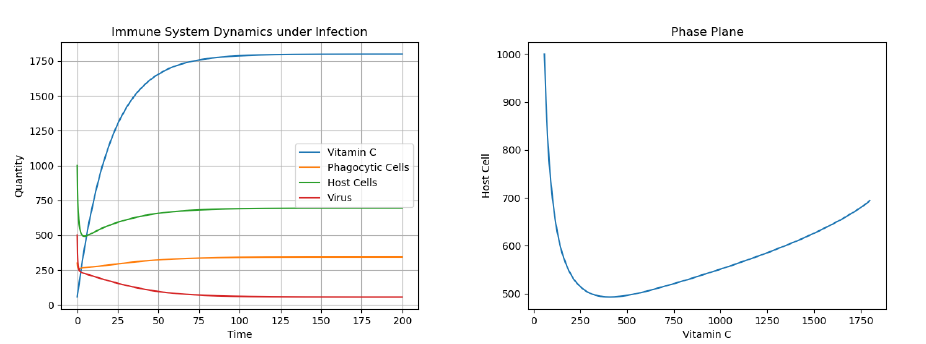
Figure 8. Dynamics under Frustrated Phagocytosis with Moderate Constant Infusion of Vitamin C